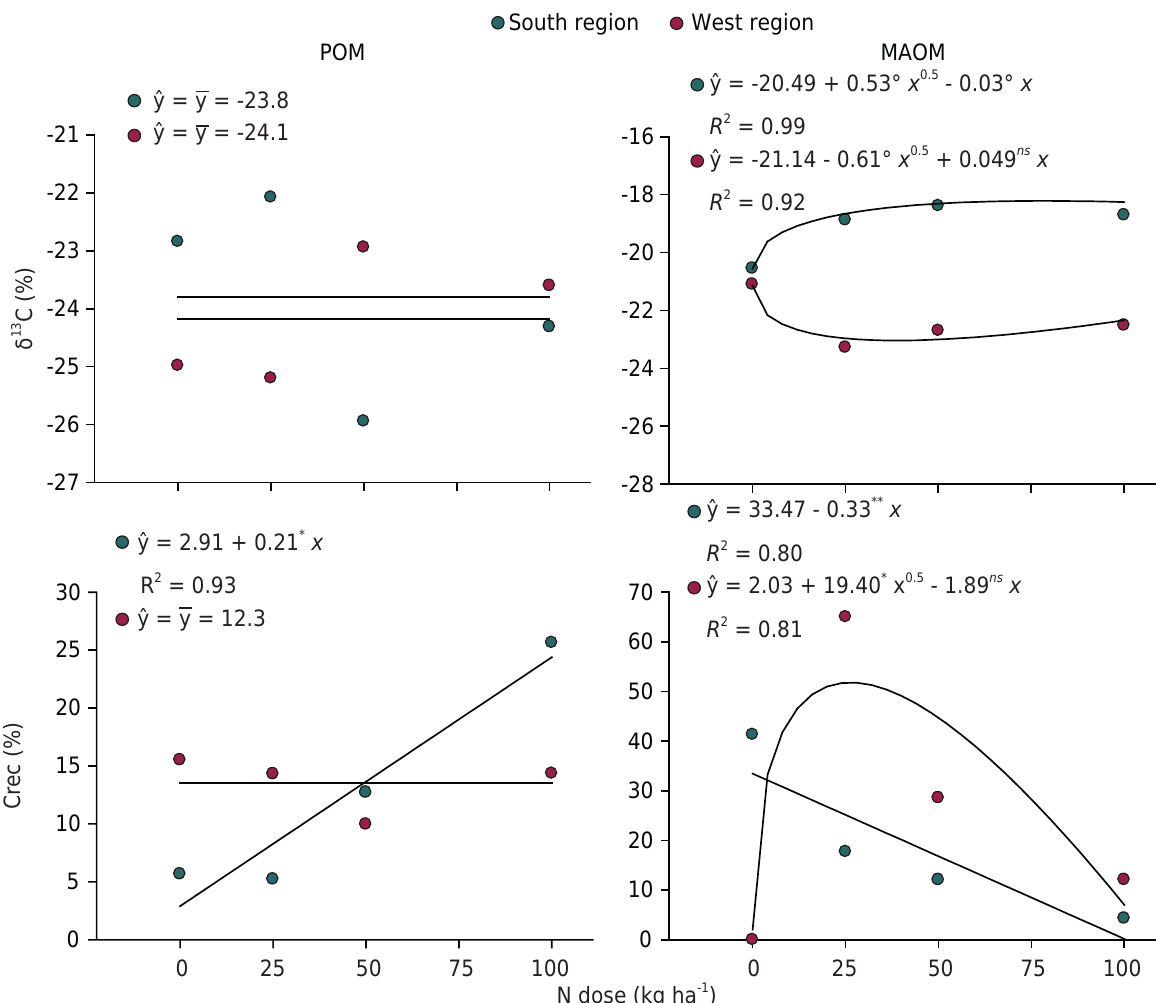
Figure 3. Recovery of residue-derived carbon (Crec) and the isotopic C ratio of SOM fractions (δ 13 C) as a function of N fertilization rates. °, * , and ** indicate equation parameters significant at 10, 5, and 1 %, respectively. ns : not